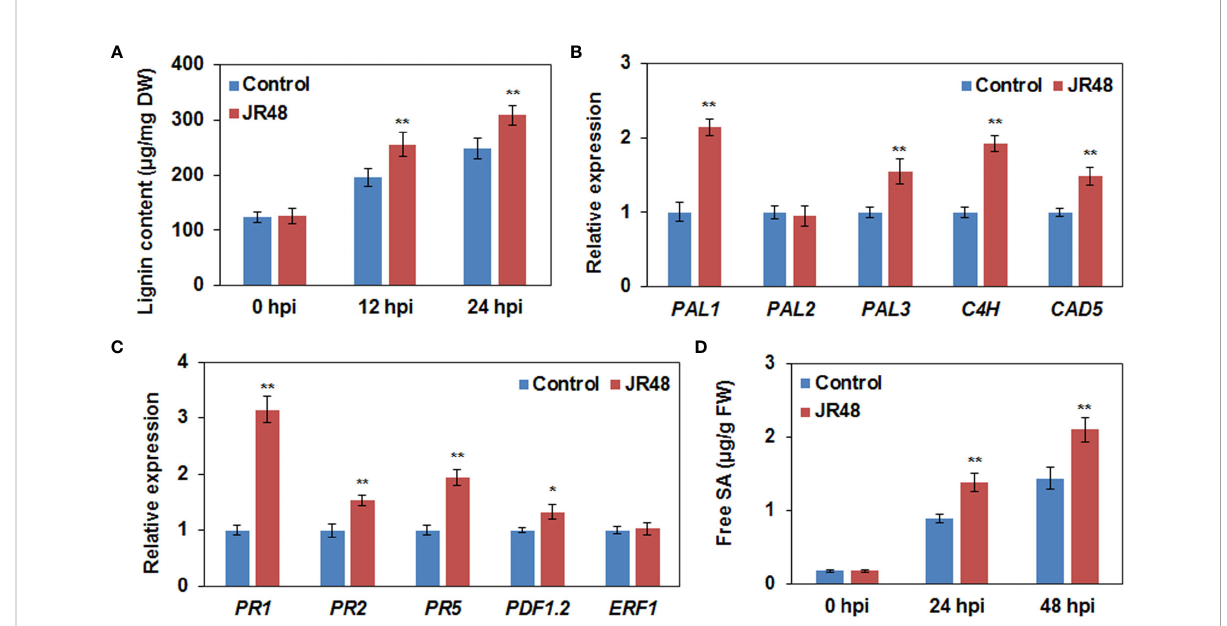
FIGURE 5 Promoted lignin biosynthesis and reinforced SA accumulation and response by JR48. (A) Lignin content during pathogen infection. Leaves of pre-treated wild-type Arabidopsis Col-0 were in fi ltrated with Xcc 8004. Lignin content was determined at the indicated time points (mean ± SD; n (number of leaves) ≥ 12; **P < 0.01, Student ’ s t -test). Experiments were repeated in triplicate. DW, dried weight. (B,C) Relative expression of genes involved in lignin biosynthesis (B) and plant hormone signaling pathway (C) . Relative expression of the indicated genes in Arabidopsis Col-0 at 12 h post Xcc infection was determined. Each value represented is mean of three replicates and error bars indicate SD. Asterisks indicate signi fi cant differences (*P < 0.05 and **P < 0.01, Student ’ s t -test). This experiment was repeated three times with similar results. (D) Free SA levels during pathogen infection. Pre-treated Arabidopsis leaves were inoculated with Xcc 8004. Free SA levels were measured at the indicated time points. Data are presented as means ± SD (n ≥ 12) calculated from three independent biological replicates (**P < 0.01, Student ’ s t -test). FW, fresh